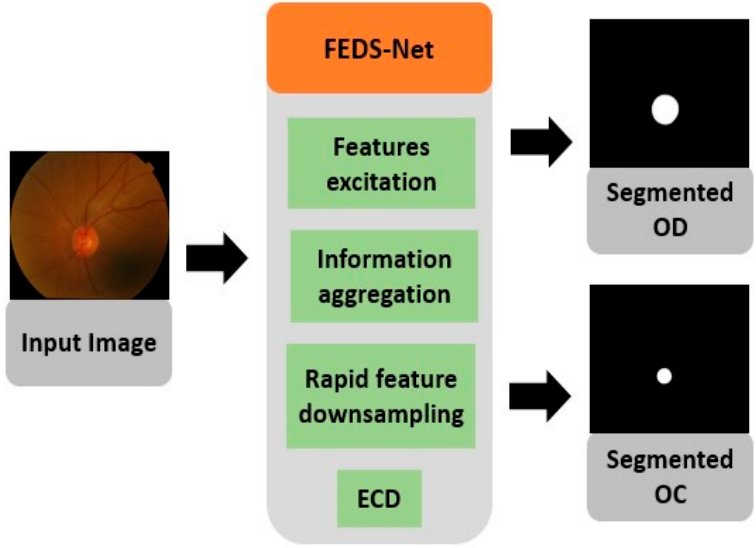
Figure 3. The overview diagram of the proposed method.